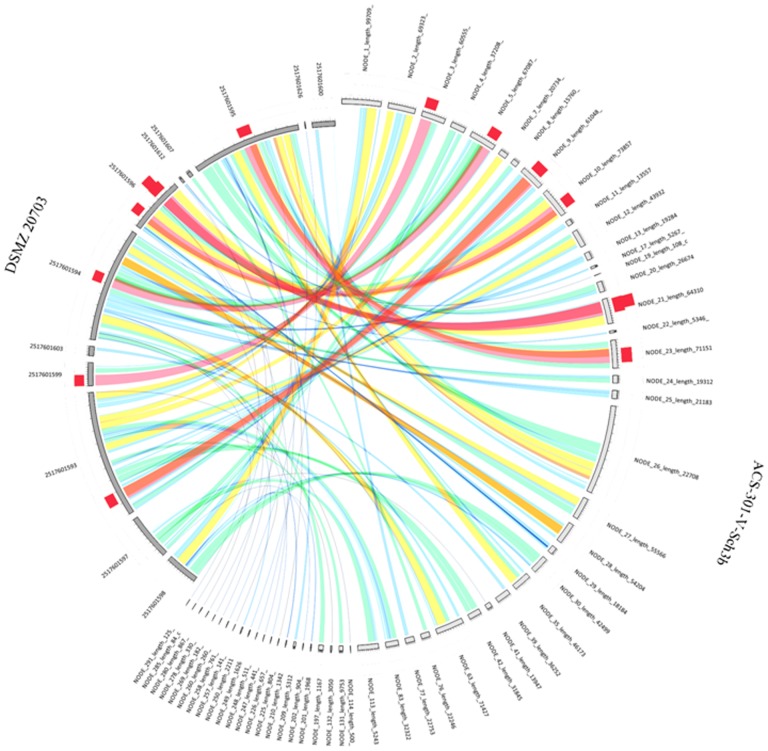
DSM 20703 V's ACS-301-V-Sch3b Synteny Map.Syntenic affinities (conserved blocks) across the whole genome sequences of ACS-301-V-Sch3b and DSM 20703 were determined using BLAST+ [133]with DSM 20703 used to build the database and using BLASTN to find synteny within the ACS-301-V-Sch3b genome. The ideogram was built using Circoletto [134] where ribbons represent the local alignments and the colours blue, green, orange and red, respectively representing the 25% blocks up to the maximum score of 100% and histogram on top of the ideograms, counting how many times each band has hit the specific part of the sequence.